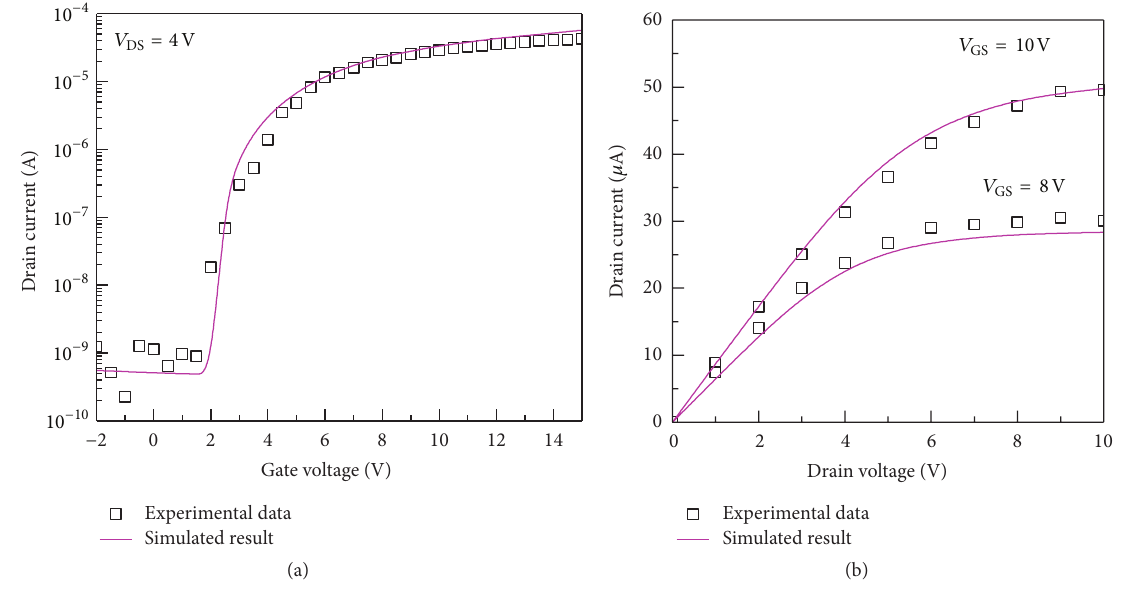
Figure 3: Characteristics of fullerene N-channel obtained from experiment and simulation: (a) transfer and (b) output.